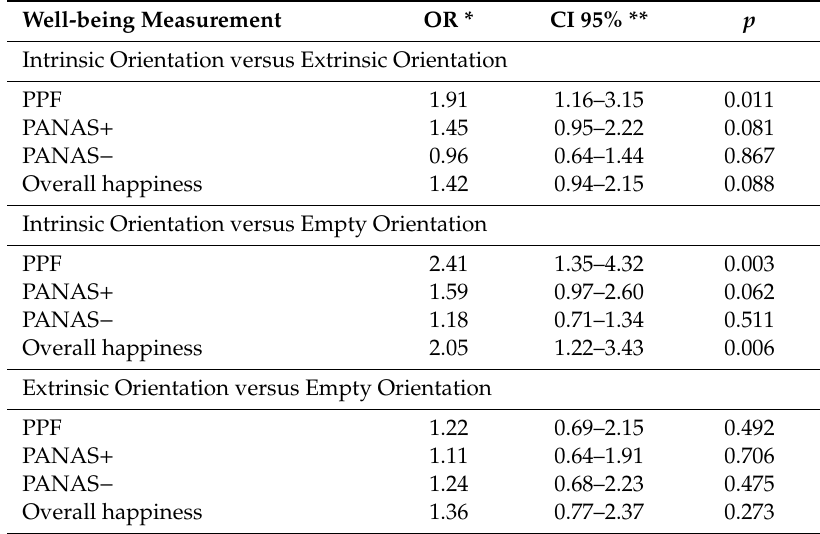
Table 3. Regression analysis of the association between type of orientation and measures of well-being. Well-being Measurement OR * CI 95% ** p Intrinsic Orientation versus Extrinsic Orientation PPF 1.91 1.16–3.15 0.011 PANAS + 1.45 0.95–2.22 0.081 PANAS − 0.96 0.64–1.44 0.867 Overall happiness 1.42 0.94–2.15 0.088 Intrinsic Orientation versus Empty Orientation PPF 2.41 1.35–4.32 0.003 PANAS + 1.59 0.062 PANAS − Overall happiness 0.006 Extrinsic Orientation versus Empty Orientation PPF 1.22 PANAS + 1.11 0.706 PANAS − Overall happiness 1.36 0.77–2.37